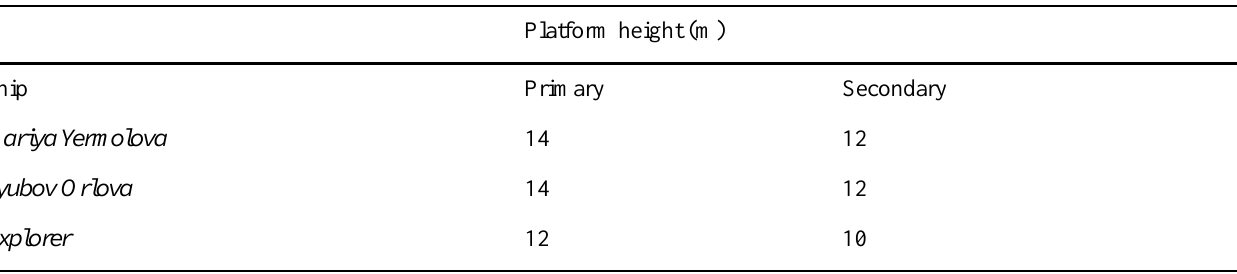
Table 1. Height of the primary observation and secondary (duplicate tracking) platforms aboard three ships of opportunity used in this